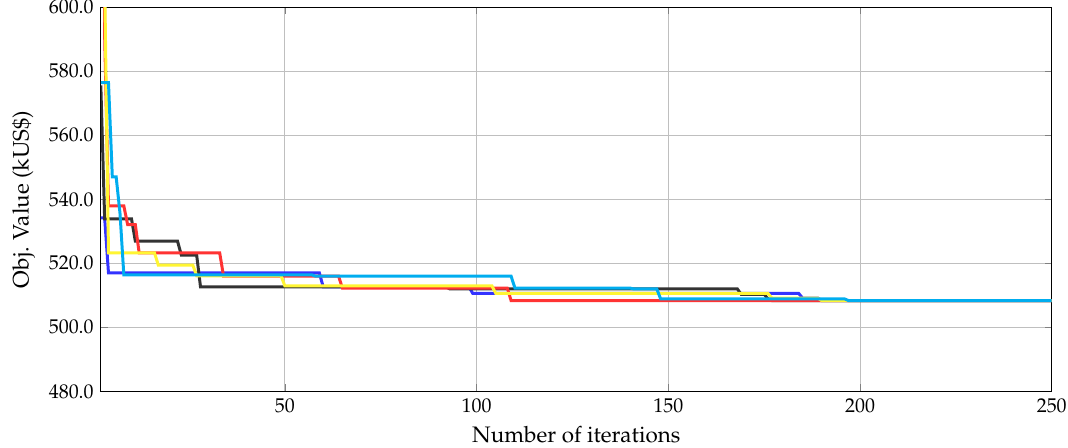
Figure 12. Behavior of the objective function value for the 8-bus system with balanced